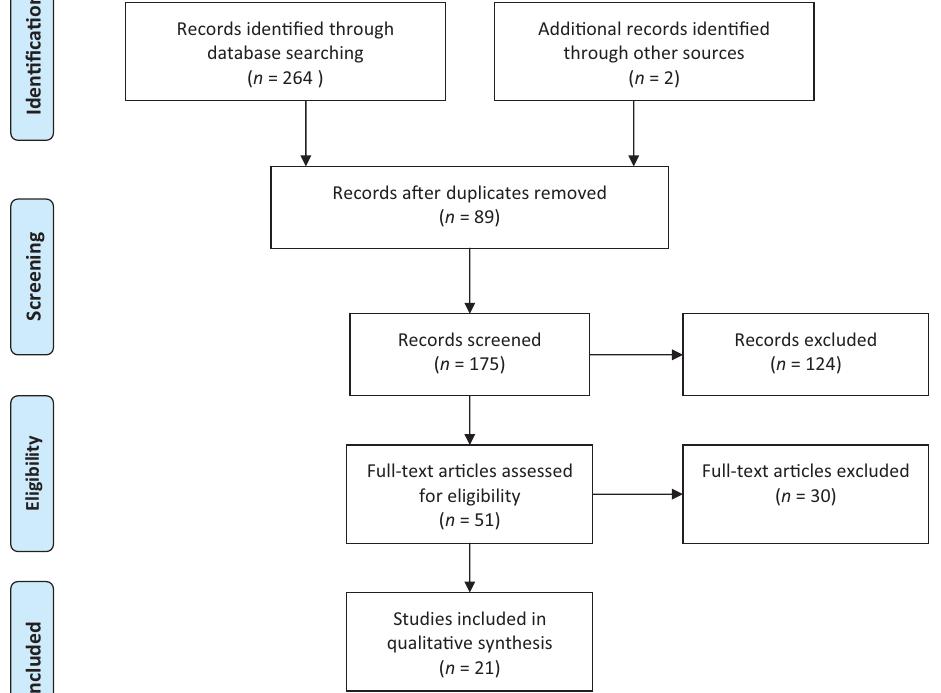
Figure 1. PRISMA 2009 flow